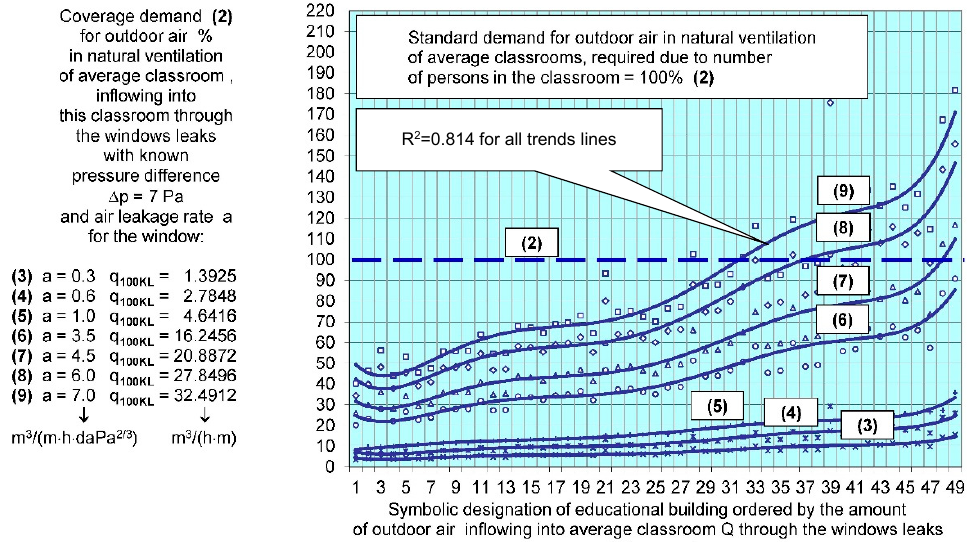
R 2 =0.814 for all trends lines